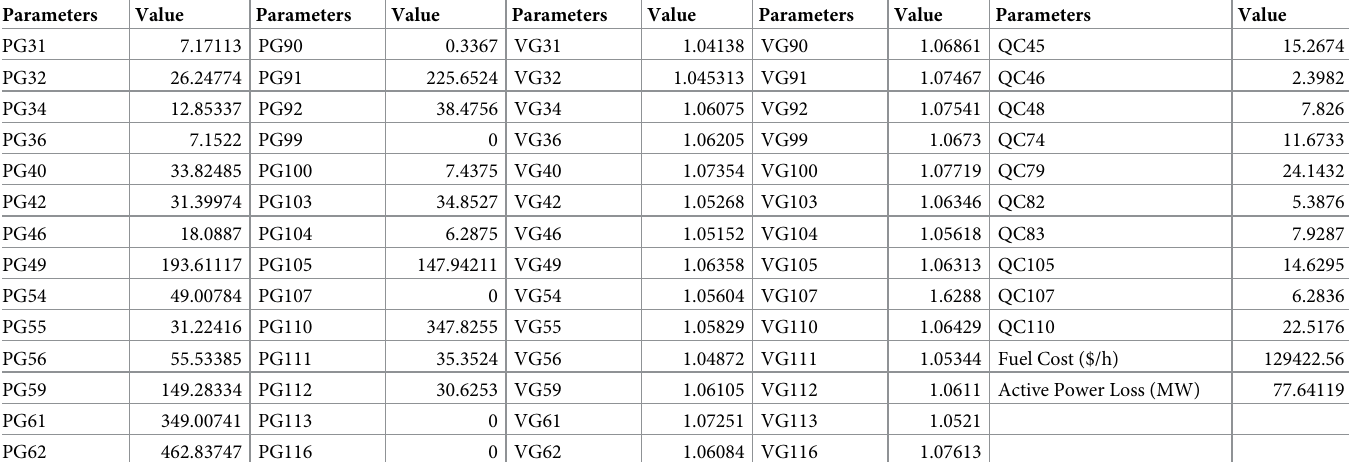
of each controlling parameter. In the exploration and exploitation stage, the distinctive levy and Brownian movements demonstrated the best global optimum solution in the search space. After the exploitation process, the MPA shows the global optima value of at 129422.56$/h for fuel cost and active power loss 74.64 MW, respectively. Additionally, the obtained fuel cost using the proposed technique with its convergence characteristics is portrayed in Fig 9.